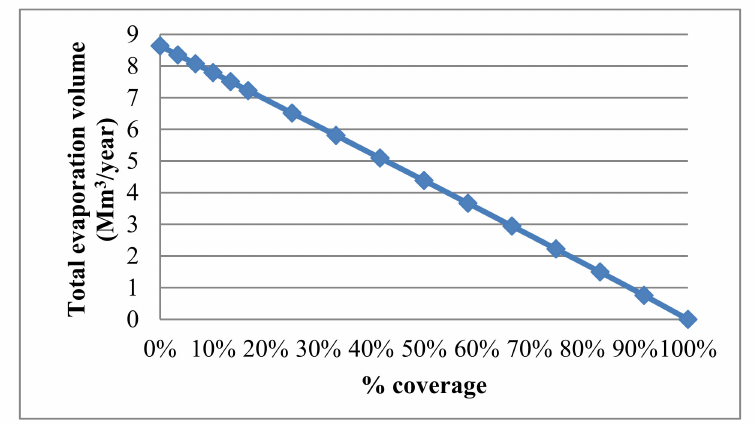
Figure 4. Evaporation volume in million m 3 / year versus percentage coverage of Sheikh Zayed Canal for the 50-km length of the